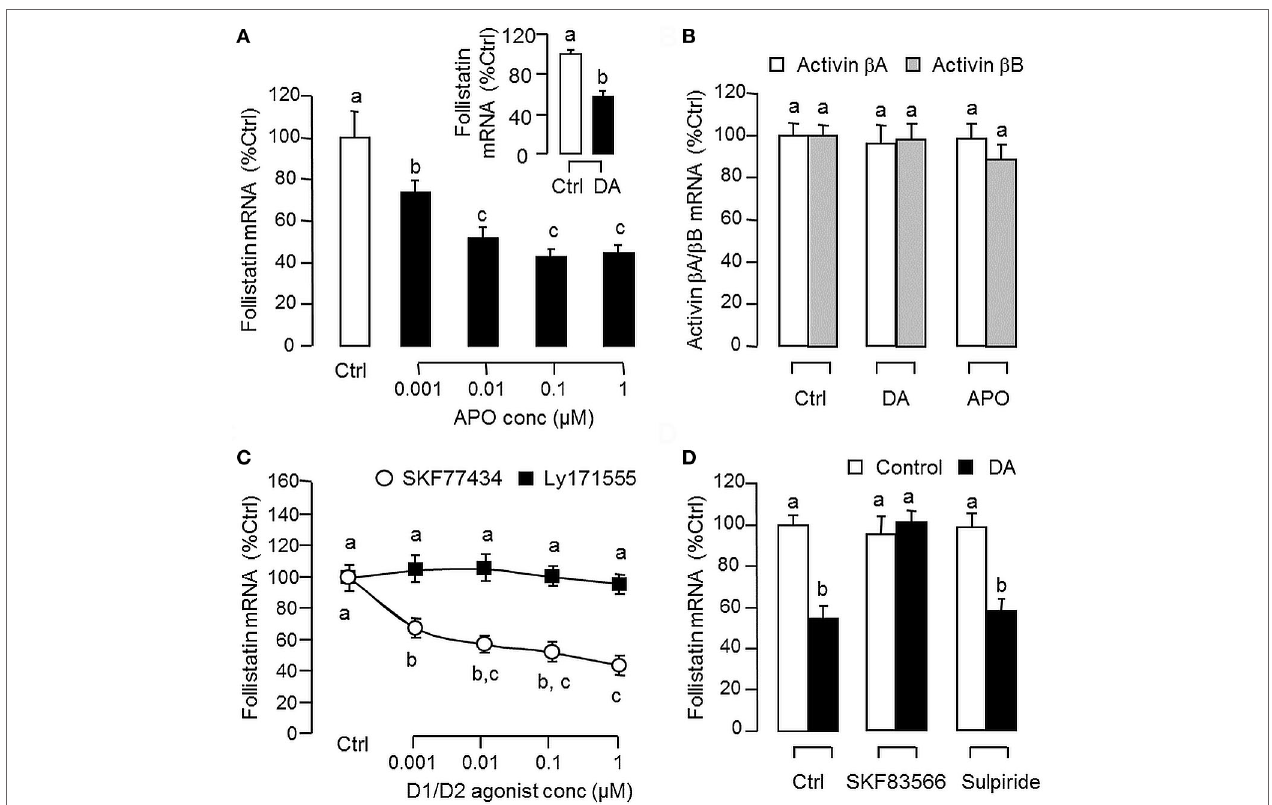
FigUre 5 | Dopaminergic regulation of follistatin and activin expression in carp pituitary cells. (a) Effects of dopamine (DA) and its non-selective agonist apomorphine (APO) on follistatin mRNA expression. Pituitary cells were treated for 24 h with increasing doses of APO (0.001–1 µM) or with a single dose of DA (1 µM). (B) Effects of DA and APO on activin β A and β B mRNA expression. Pituitary cells were treated for 24 h with DA (1 µM) or APO (1 µM). (c) Effects of DA D1 and D2 agonists on follistatin mRNA expression. Pituitary cells were treated for 24 h with increasing doses of the DA D1 agonist SKF77434 or D2 agonist Ly171555 as indicated. (D) DA D1 and D2 antagonists on the inhibitory effect of DA on follistatin mRNA expression. Pituitary cells were challenged with DA (1 µM) for 24 h in the presence or absence of the DA D1 antagonist SKF83566 (5 µM) or D2 antagonist sulpiride (5 µM). In these studies, total RNA was isolated after drug treatment and subjected to real-time PCR measurement for follistatin, activin β A, and activin β B mRNA, respectively. Data presented are pooled from four experiments ( N = 4) and the groups denoted by different letters represent a significant different at P <